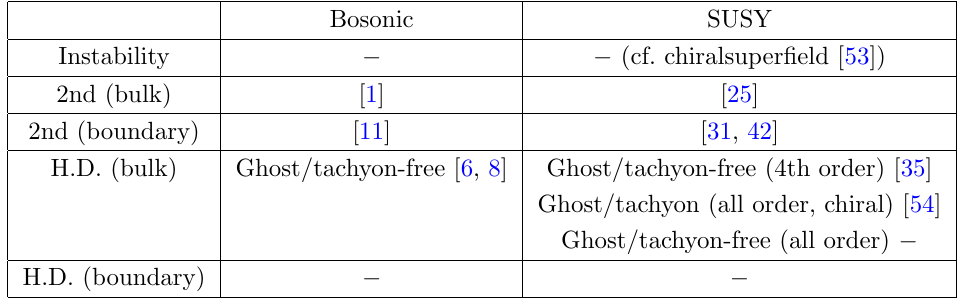
Table 1 . Higher derivative Lagrangians of 3-form gauge theories. \2nd" and \H.D." imply second order canonical term and higher derivative term, respectively. \ (cid:0) " implies that it has not been done and will be done in this paper. The reason why we list chiral super(cid:12)eld is that 3-form gauge theories can be formulated in terms of a chiral